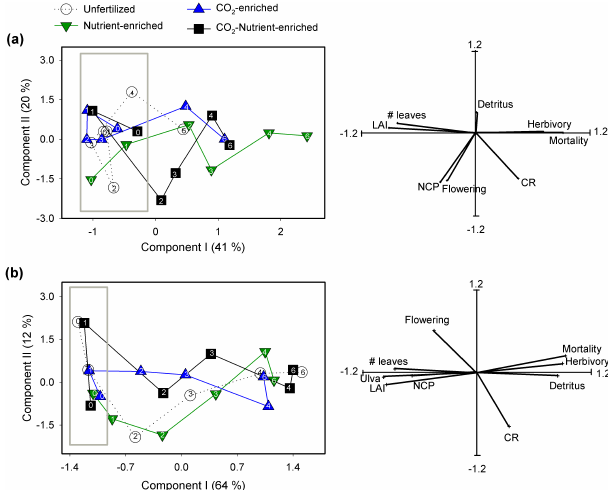
Figure 4. PCA of Zostera noltii plant-, community-, and ecosystem- level responses to treatments through time: (a) low-nutrient and (b) high-nutrient meadow. Numbers inside the symbols indicate sampling weeks from 0 to 6. The initial variability (week 0) along component I is incorporated within a grey rectangle to highlight the range of initial natural variability. Variable loadings on the two principal components are depicted in the right-hand graphs. NCP, net community production; CR, community